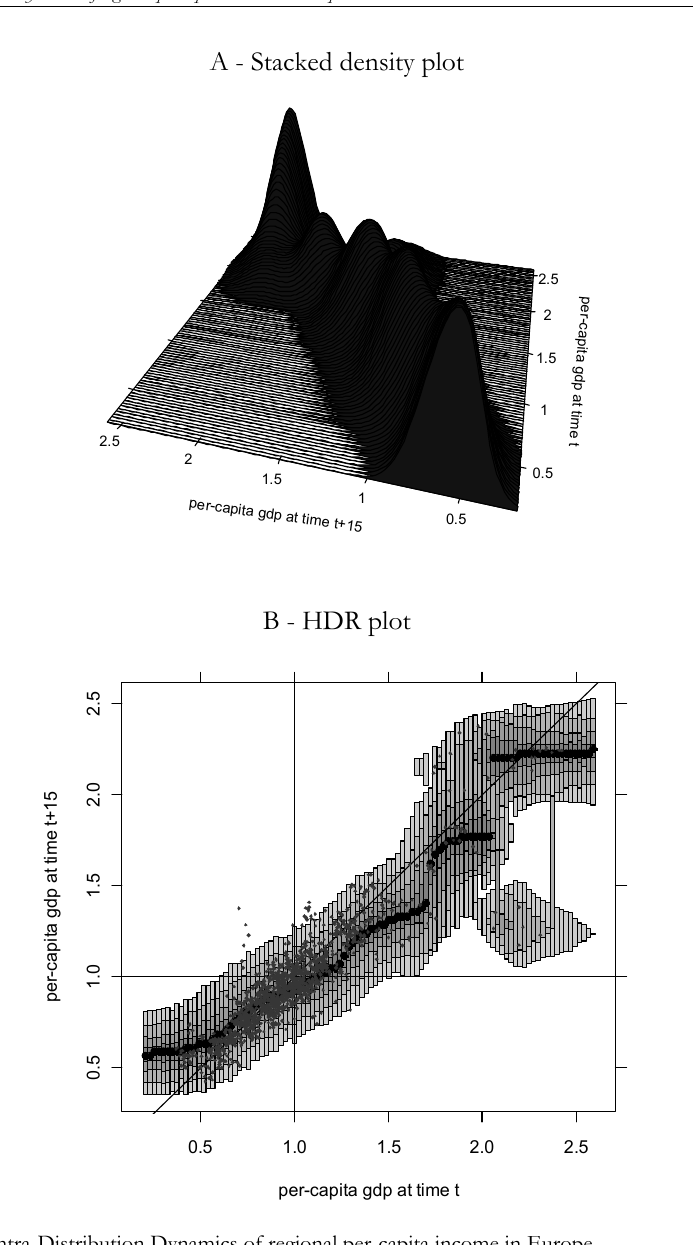
Figure 3 – Intra-Distribution Dynamics of regional per-capita income in Europe. Stacked density plot and HDR plot of conditional density for transitions of 15 years between 1980- 2002. Estimates are based on a kernel density estimator with fixed bandwidths (a = 0.132; b =